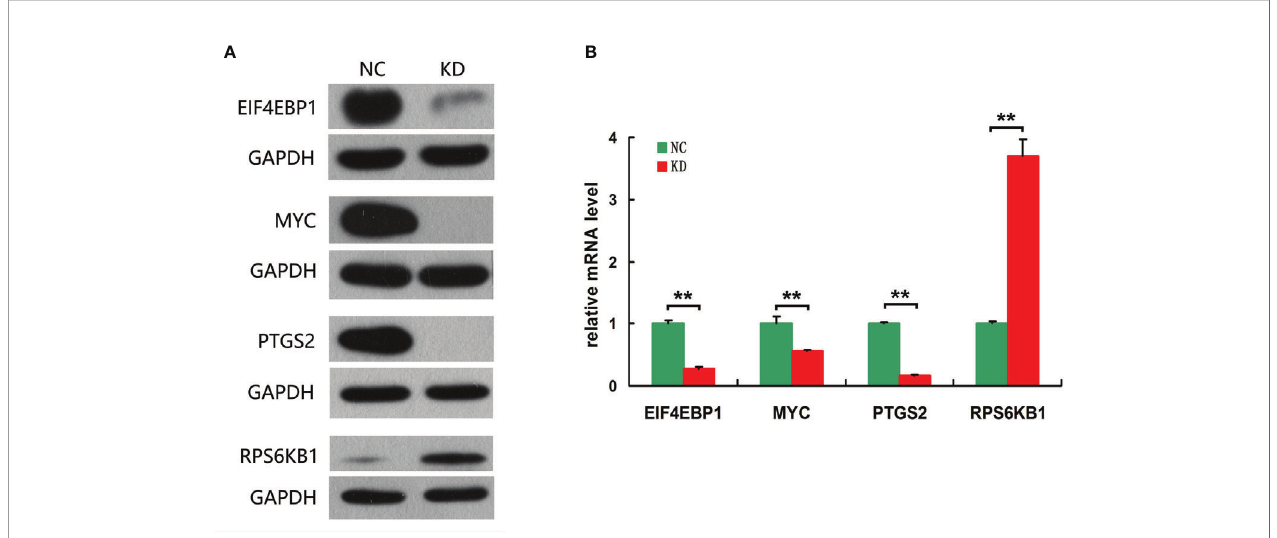
FIGURE 6 | Veri fi cation the expression of 4 downstream regulatory factors related to the proliferation and apoptosis. (A) EIF4EBP1, MYC and PTGS2 were signi fi cantly down-regulated, while RPS6KB1 was dramatically up-regulated in protein level. (B) EIF4EBP1, MYC and PTGS2 were signi fi cantly down-regulated, while RPS6KB1 was dramatically up-regulated in mRNA